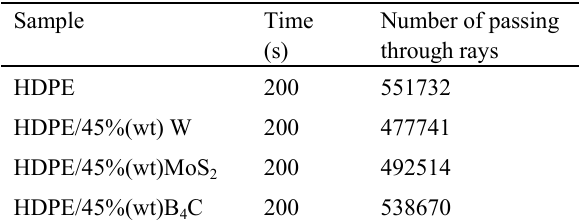
Table 4. Scintillator Result with Co Source for Neat HDPE, HDPE/45%(wt) tungsten, HDPE/45%(wt) boron carbide, HDPE/45%(wt) molybdenum disulfide Sample Time Number of passing (s) through rays HDPE 200 551732 HDPE/45%(wt) W 200 477741